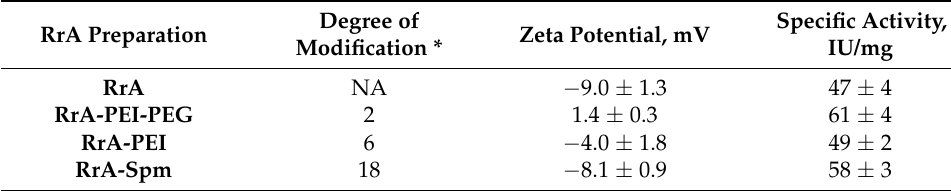
Table 4. Zeta potential and specific activity values of native RrA and its conjugates. The hydrolysis activity of 20 mM L-Asn was measured in 10 mM PBS pH 7.5 at 37 ◦ C. Specific Activity, Degree of Zeta Potential, mV RrA Preparation IU/mg Modification * RrA NA − 9.0 ± 1.3 47 ± 4 RrA-PEI-PEG 2 1.4 ± 0.3 61 ± 4 RrA-PEI 6 − 4.0 ± 1.8 49 ± 2 RrA-Spm 18 − 8.1 ± 0.9 58 ± 3